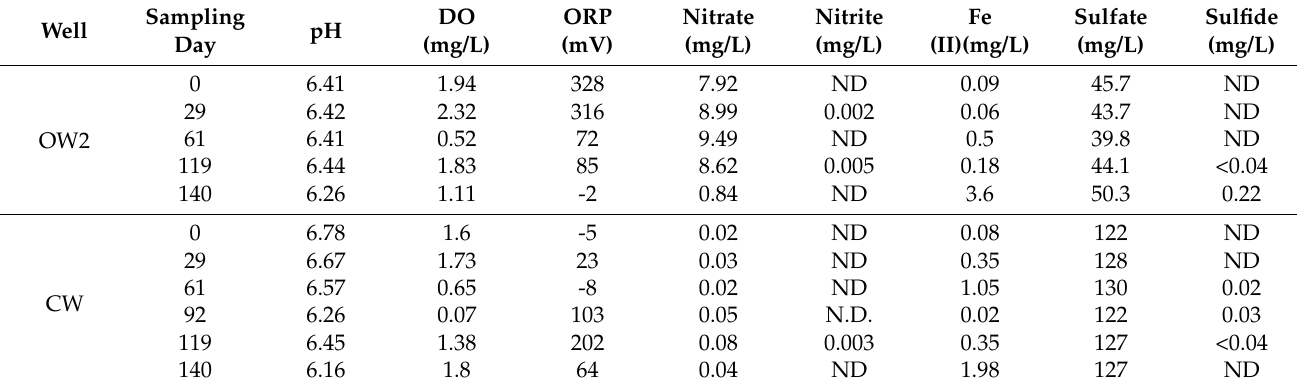
Table 1. Environmental water quality parameter comparison of OW2 and CW in the in situ field testing. Well